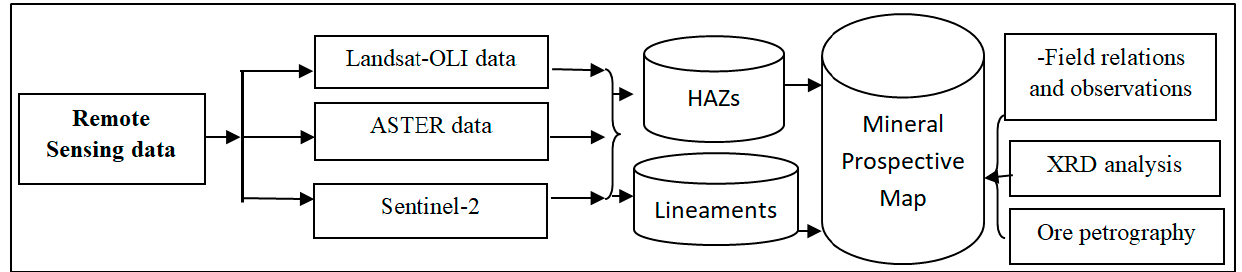
Figure 2. Flow chart shows the implemented data and methods in the present study to delineate the mineral prospective map.